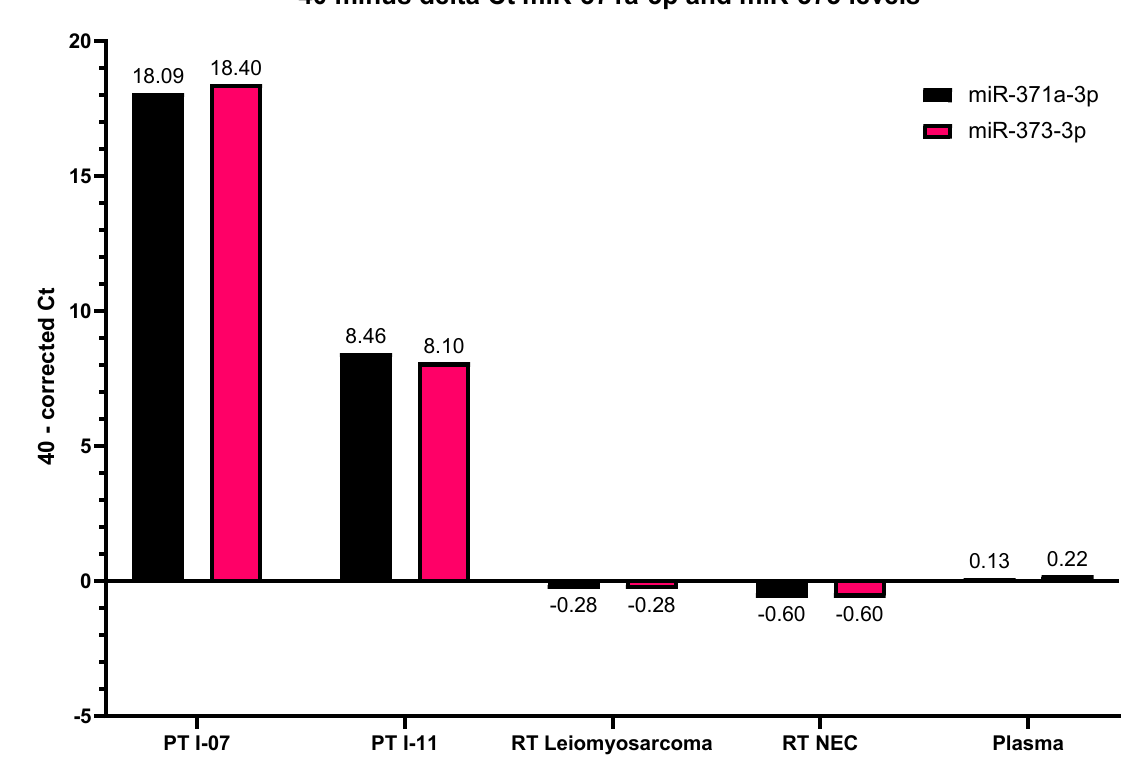
Figure 3. High levels of embryonic miRNAs 371a-3p and 373-3p in the primary tumor sections PT I-07 and intermediate levels thereof in PT I-11, due to the high percentage of teratoma (known to be negative for these miRNAs), and negative results for both the leiomyosarcoma and NEC elements, as well as matched plasma.